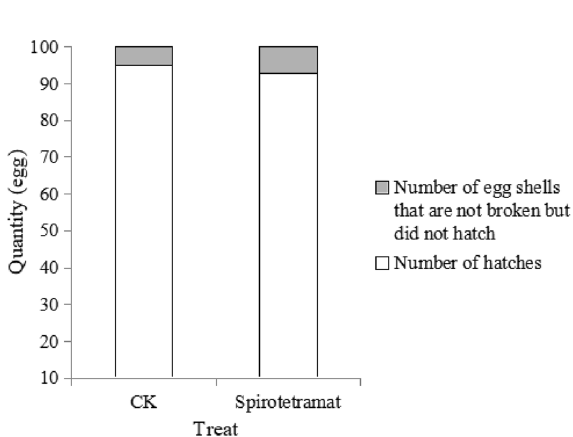
Figure 6. The effect of spirotetramat on hatching rate of F. occidentalis 24-h-old